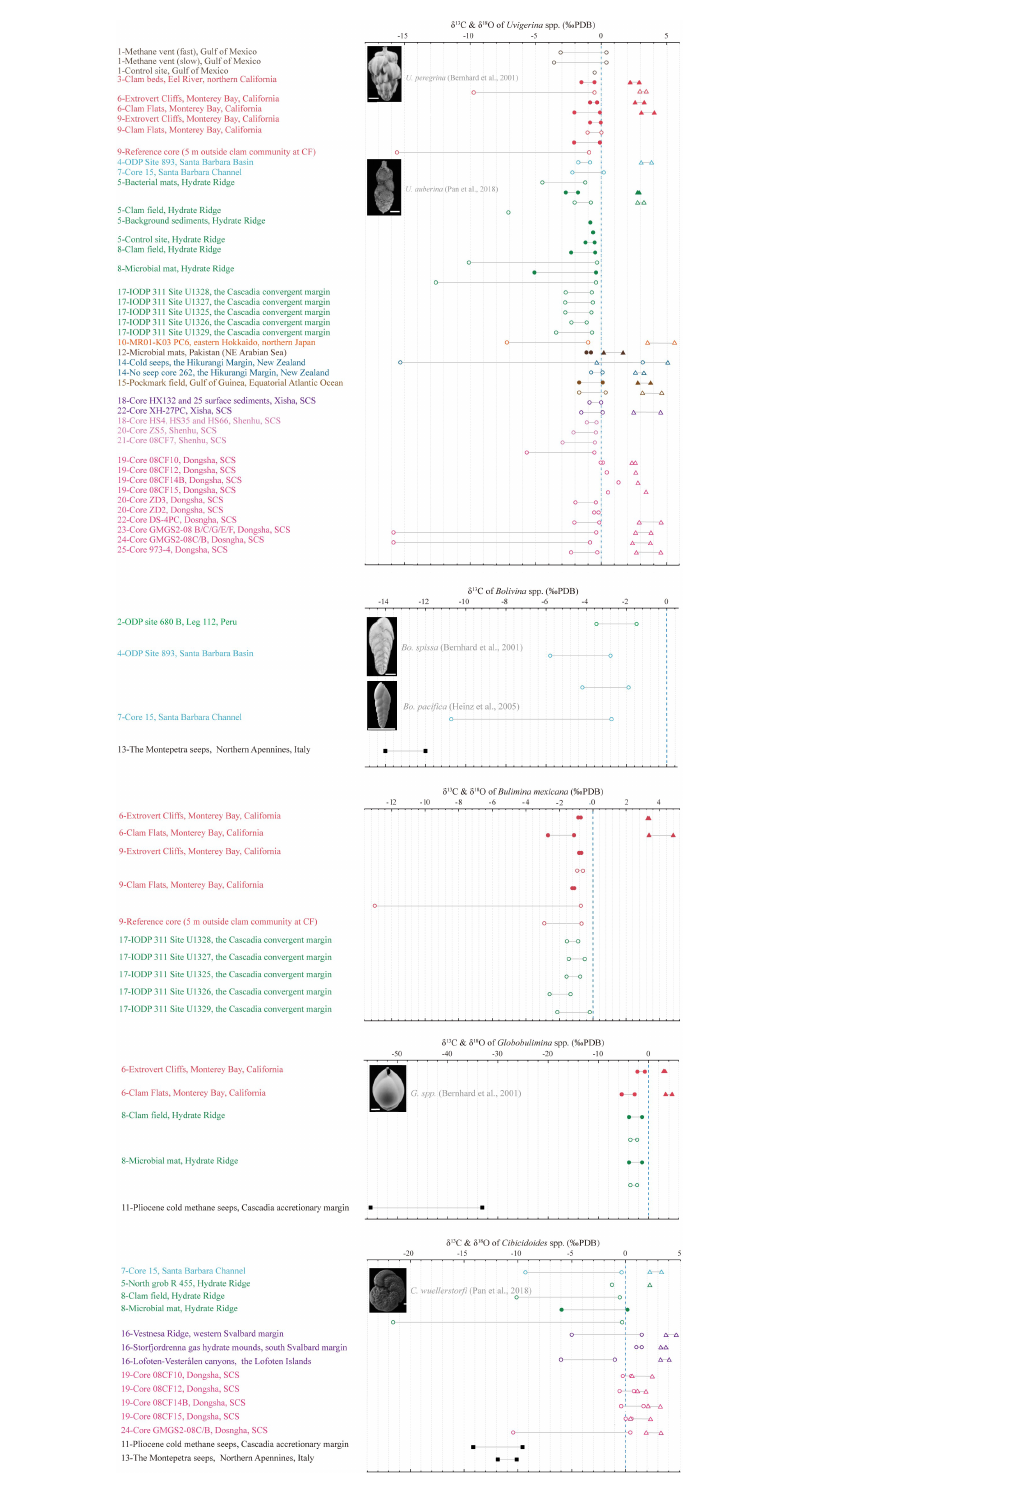
FIGURE 4 Summary of carbon and oxygen isotopic records of benthic foraminifera in seep sediments. The most commonly adopted endobenthic species ( Uvigerina spp., Bolivina spp., Bulimina mexicana , and Globobulimina spp.) and epibenthic species ( Cibicidoides spp.) are selected. d 13 C values of live and dead benthic specimens are represented by solid dots and open circles, respectively. Similarly, d 18 O values are represented by triangles. The black square represents the d 13 C results of ancient seep samples. The solid gray line in the middle of two symbols represents the fl uctuation range of the isotopic value, but it does not mean continuous change. Dotted blue line is a guide for the normal marine average d 13 C BF value, which is selected as 0 ‰ PDB here. Please refer to Appendix Table 2 for data